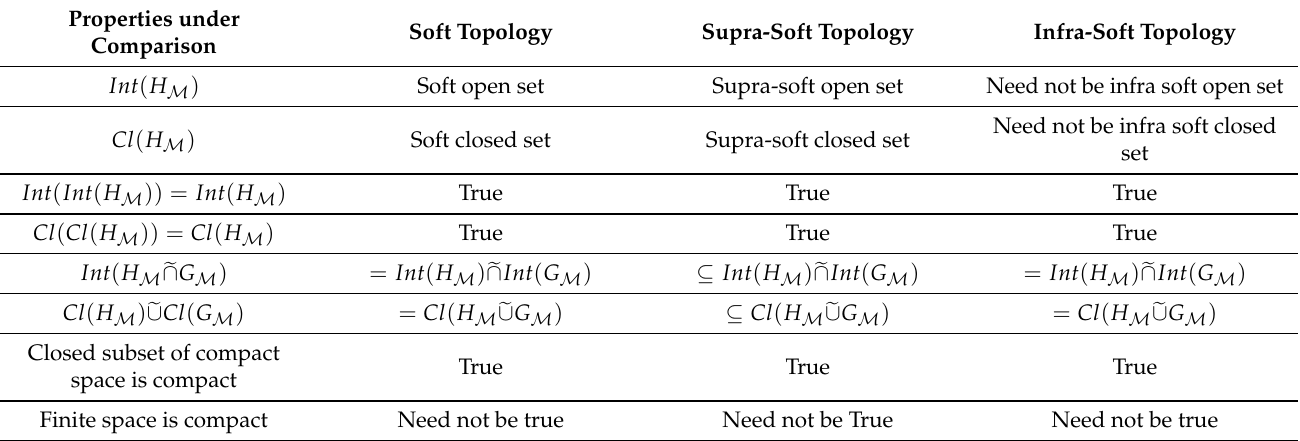
Table 1. Description of some properties via soft topology, supra-soft topology, and infra-soft topology.